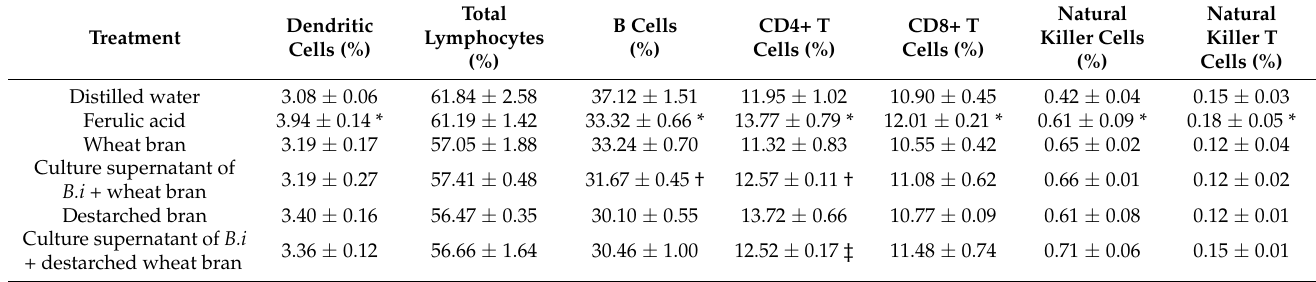
Values represent the percentage of total splenocytes and are expressed as the mean + standard errors of the mean. N = 3 mice. Statistical analysis by Mann–Whitney U test. * p < 0.05 vs. distilled water; † p < 0.05 vs. wheat bran; ‡ p < 0.05 vs. destarched bran. B.i , Bacteroides